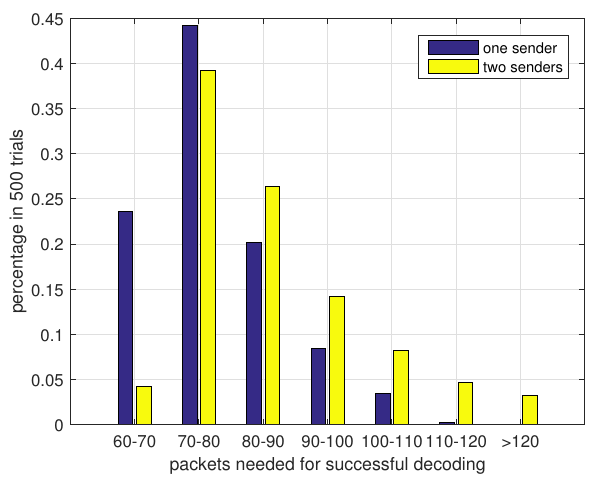
Figure 9. The percentage of packets for successful decoding in 500